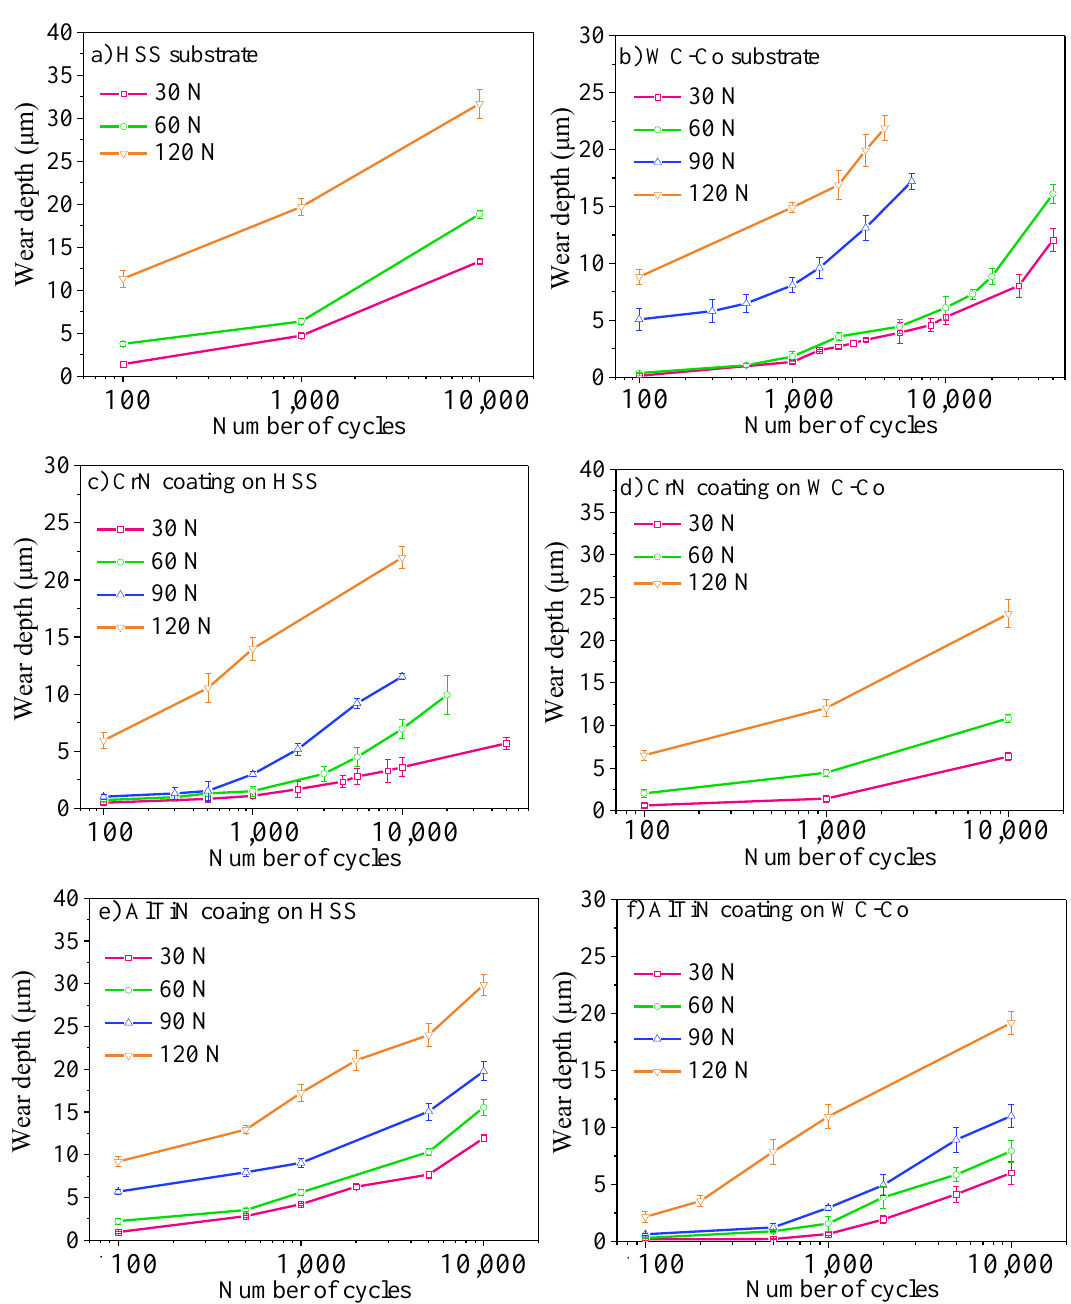
Figure 7. Wear depths: ( a ) HSS substrate; ( b ) WC-Co substrate; ( c ) CrN coating on HSS; ( d ) CrN coating on WC-Co; ( e ) AlTiN coating on HSS; ( f ) AlTiN coating on WC-Co.